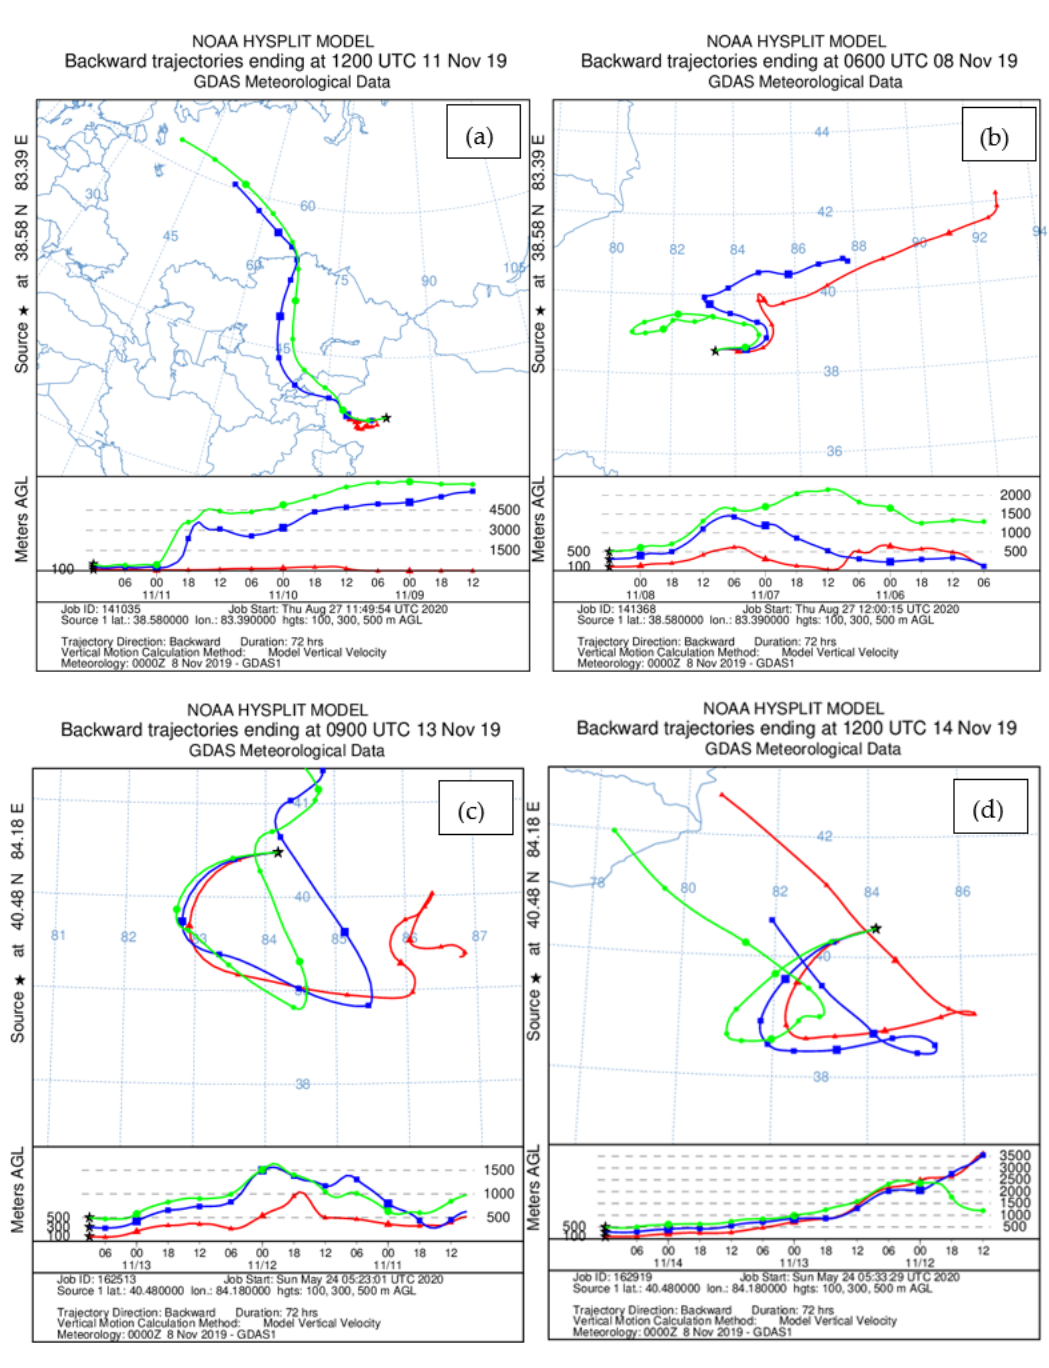
Figure 15. Backward trajectory of the air mass calculated at ( a ) 12:00 UTC (Coordinated Universal Time) on 11 November (floating dust period), 2019, at Tazhong; ( b ) 06:00 UTC on 8 November (clear period), 2019, at Tazhong; ( c ) 09:00 UTC on 13 November (sand blowing period), 2019, at Xiaotang; ( d ) 12:00 UTC on 14 November (clear period), 2019, at Xiaotang.